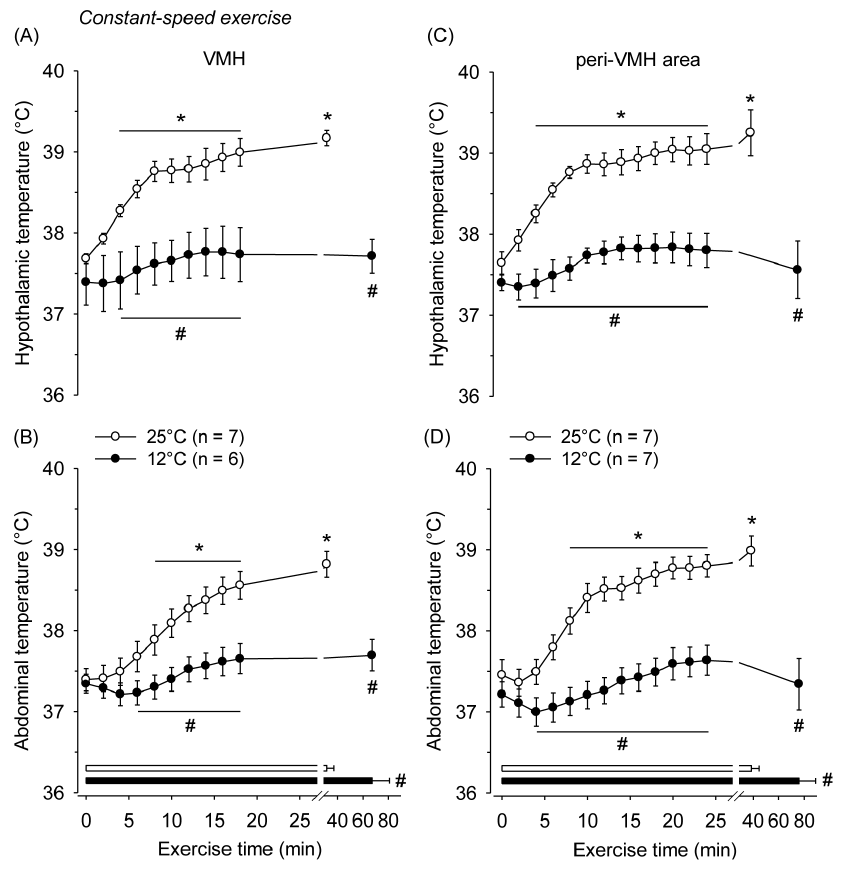
Figure 4. Body core temperature measured in the VMH (panel A), peri-VMH area (panel C) and abdomen (panels B and D) during constant-speed exercises that were performed until volitional fatigue at ambient temperatures of 25 u C and 12 u C. The horizontal bars indicate the total exercise time at 25 u C (white bar) and 12 u C (black bar). * P , 0.05 compared with the beginning of exercise at 25 u C; # P , 0.05 compared with the experimental trial at 25 u